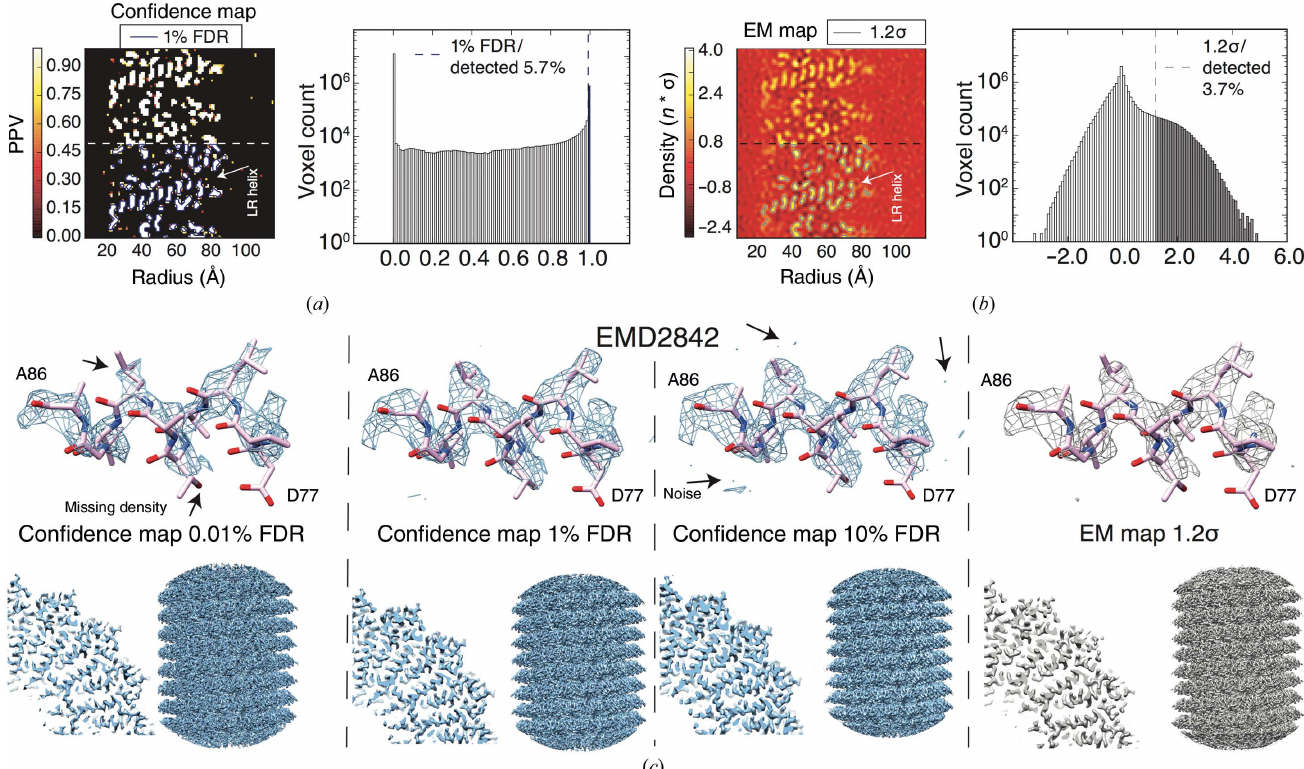
Figure 2 Confidence maps separate signal from noise for molecular-density interpretation. ( a ) Left: confidence map with a longitudinal section through the TMV coat protein displayed, indicating the (cid:3) -helical pitch of the LR helix. The lower half shows the chosen contour at 1% FDR in blue with 5.7% of voxels detected. Right, the corresponding histogram of the confidence map with signal separated above 0.99 PPV (1% FDR). ( b ) Left: the same section as in ( a ) from cryo-EM density and the recommended threshold contoured at 1.2 (cid:2) in gray with 3.7% of voxels detected. Right: the corresponding histogram of the cryo-EM density with thresholded values displayed in gray. ( c ) Isosurface-rendered thresholded confidence maps at 0.01%, 1% and 10% FDR (left, center left and center right, respectively) shown in blue and sharpened cryo-EM density with a 1.2 (cid:2) threshold (right) in gray from TMV (EMD-2842). Shown are helix Ala86–Asp77 (top), a quarter cross-section (bottom left) and a side view (bottom right) of the TMV